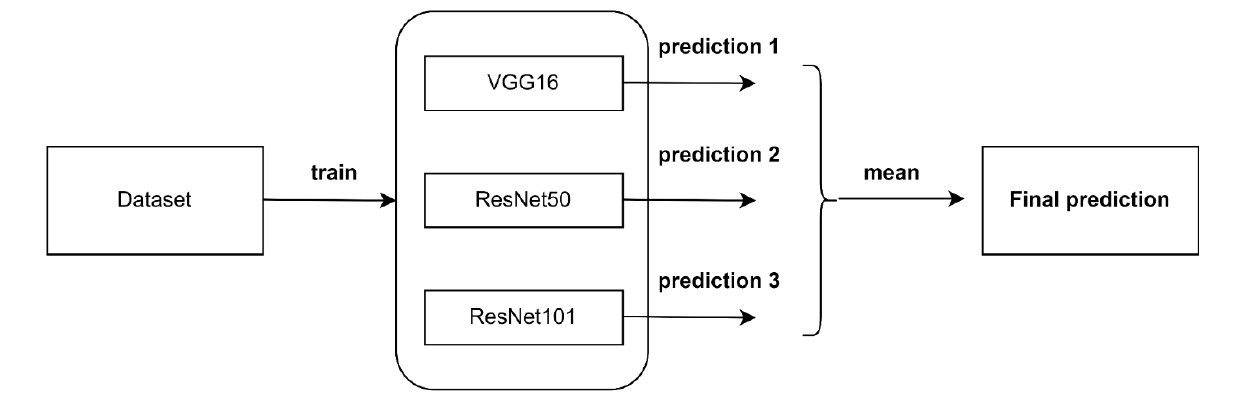
Figure 7. Ensemble algorithm.